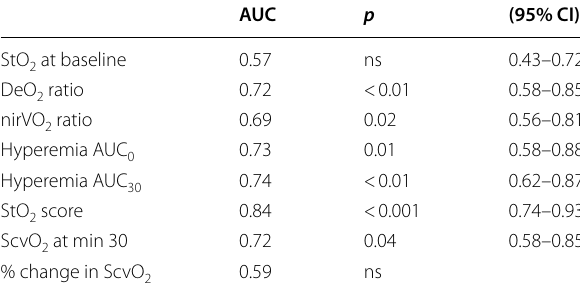
DeO 2 ratio quotient between StO 2 -deoxygenation rate at the end of SBT and at baseline, nirVO 2 ratio quotient between NIRS-derived local oxygen consumption at the end of SBT and at baseline, H AUC area under the curve of the hyperemic response, StO 2 tissue oxygen saturation, ScvO 2 central venous oxygen saturation, % change in ScvO 2 refers to the % change in ScvO 2 at min 30 of the SBT as compared to baseline ScvO